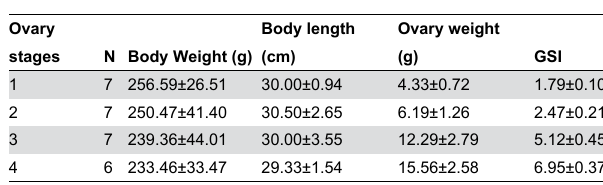
Table 2. Lists of ovary maturation stage, the number of shrimp (N), average body weight, body length, ovary weight and GSI of the wild P. monodon samples used in real-time PCR analysis.